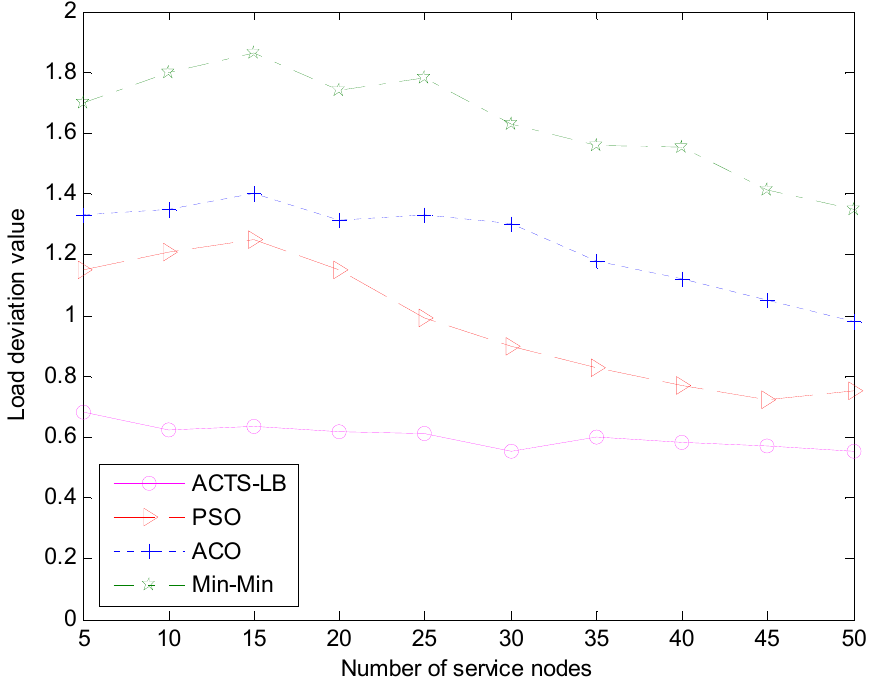
Figure 10. The comparison of system load deviation values under different service nodes.